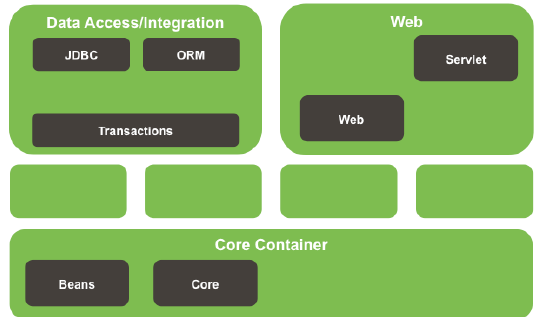
Figure 8. The modules of the Spring framework used to develop the